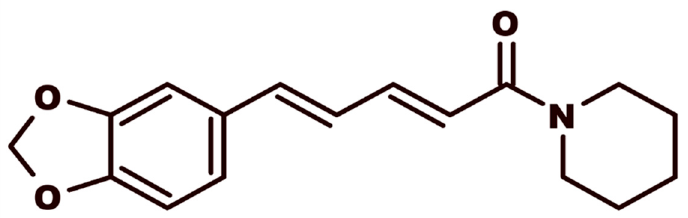
Figure 1. Chemical structure of piperine